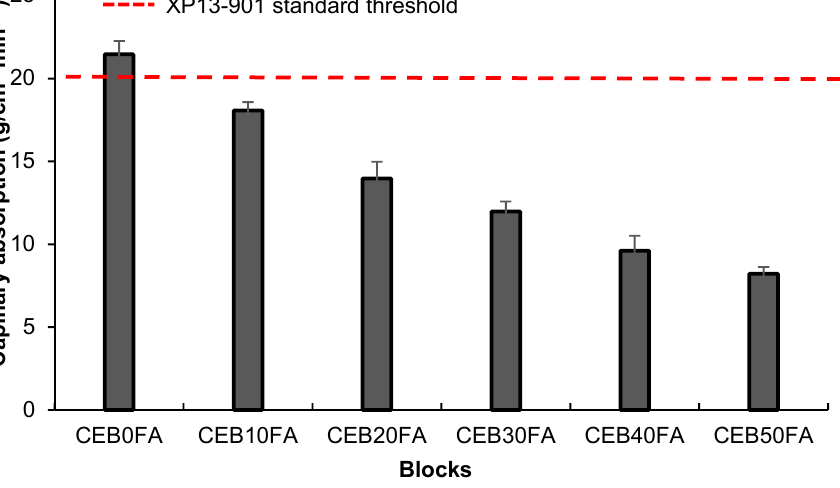
Figure 10. Capillary water absorption coefficient of different CEBs.